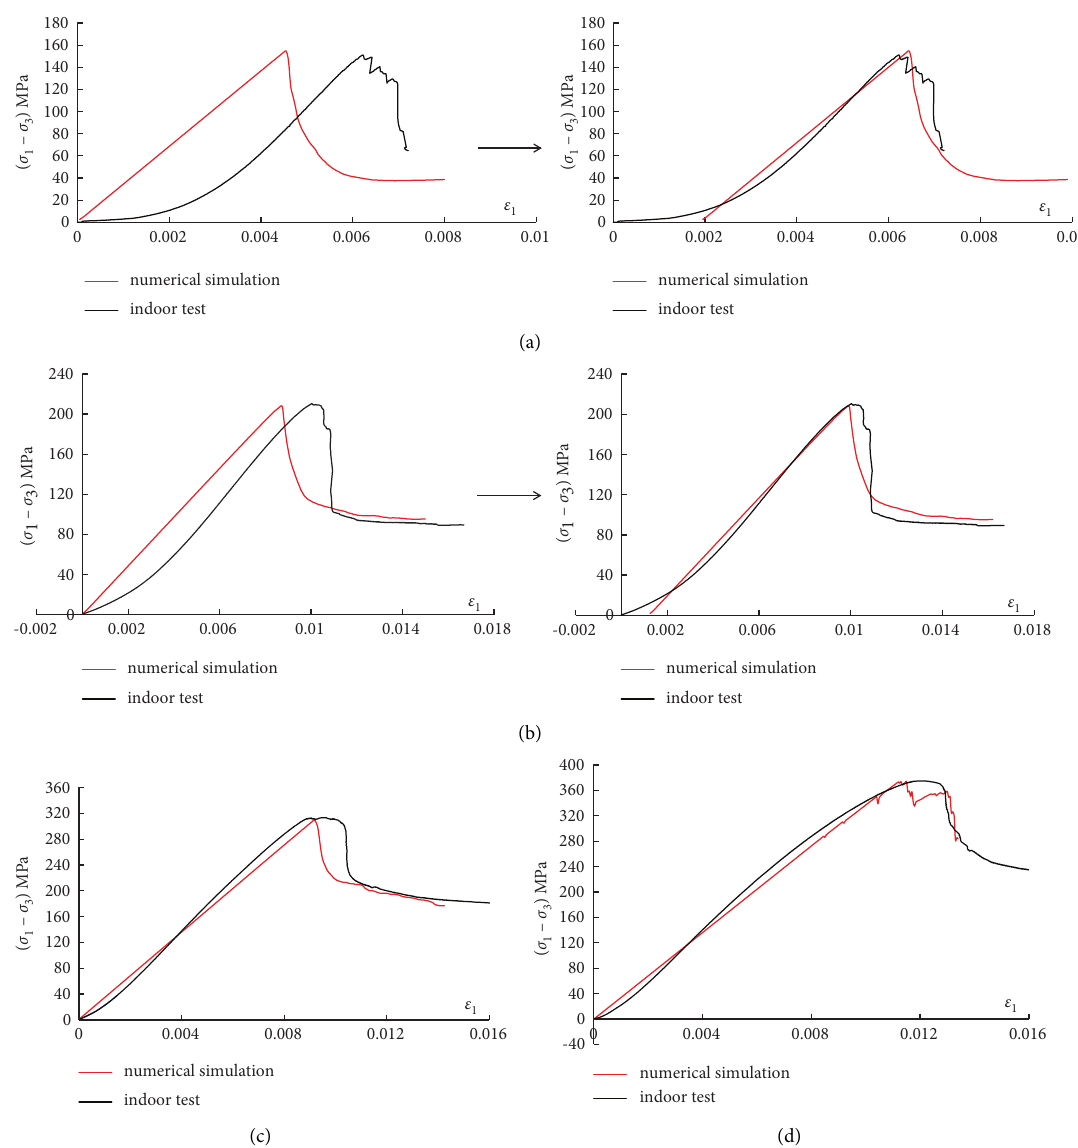
Figure 4: Contrast between numerical simulation and rock experiments under different confining stresses: (a) confining stress 0MPa, (b) confining stress 10MPa, (c) confining stress 30 MPa, and (d) confining stress